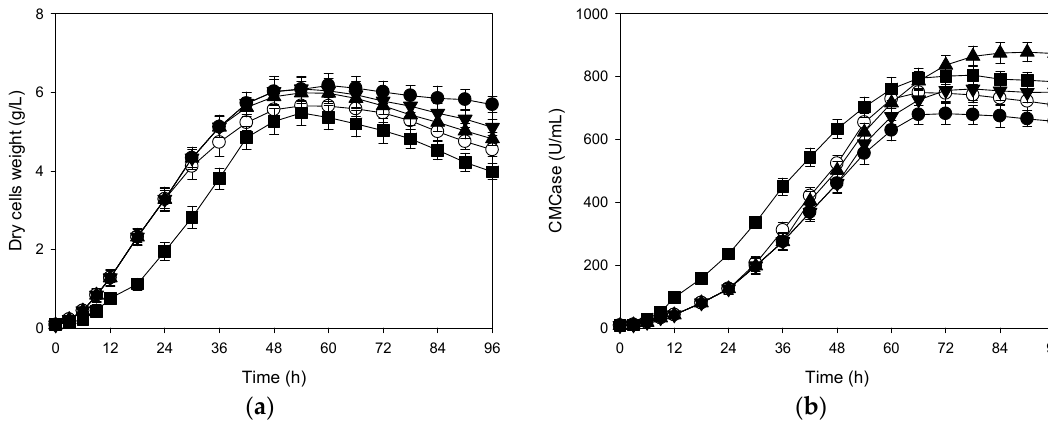
Figure 2. Effects of shift in agitation speed on ( a ) cell growth and ( b ) production of CMCase by E. coli KACC 91335P ( ● , constant at 500 rpm; ■ , shift in agitation speed from 500 to 416 rpm at 24 h; ▲ , shift in agitation speed from 500 to 416 rpm at 36 h; ▼ , shift in agitation speed from 500 to 416 rpm at 48 h; and ○ , constant at 416 rpm).